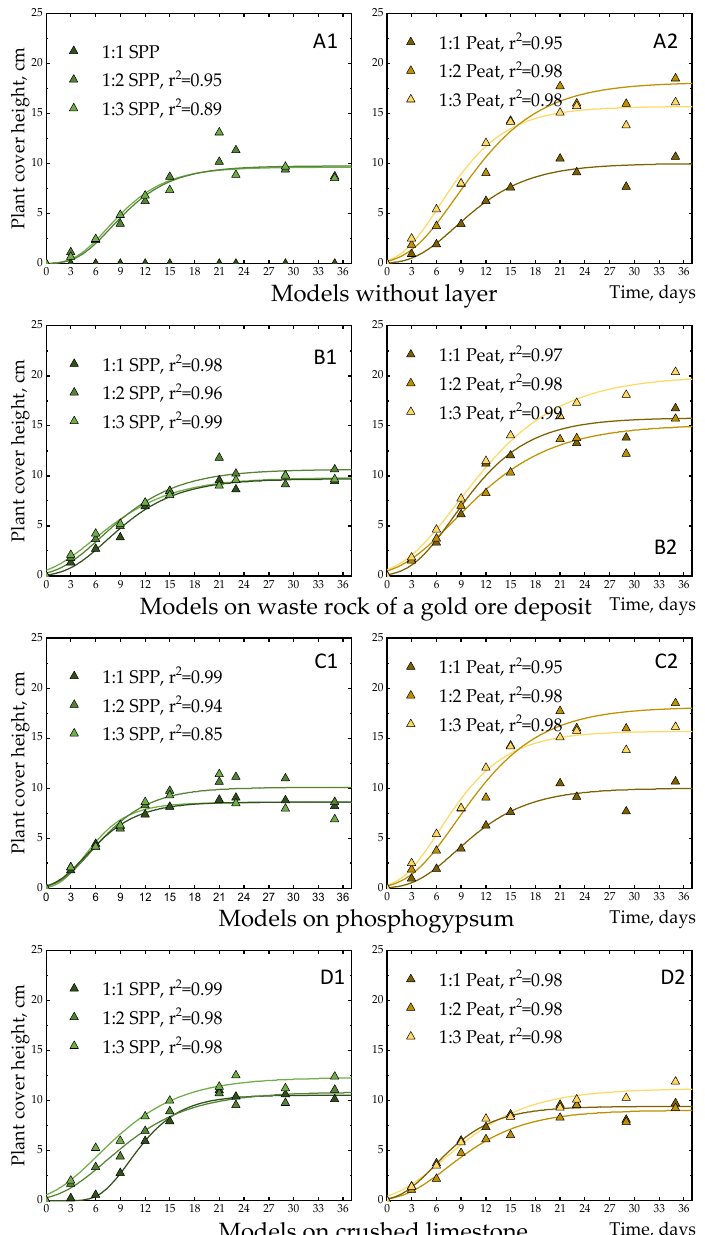
Figure 8. Rate of plant cover height (cm): A—on the model without layer, B—on the waste rock of a gold ore deposit, C—on phosphogypsum, D—on crushed limestone, ( A1 , B1 , C1 , D1 )—on a mixture of soil and wastewater sludge SPP, and ( A2 , B2 , C2 , D2 )—on a mixture of soil and peat.